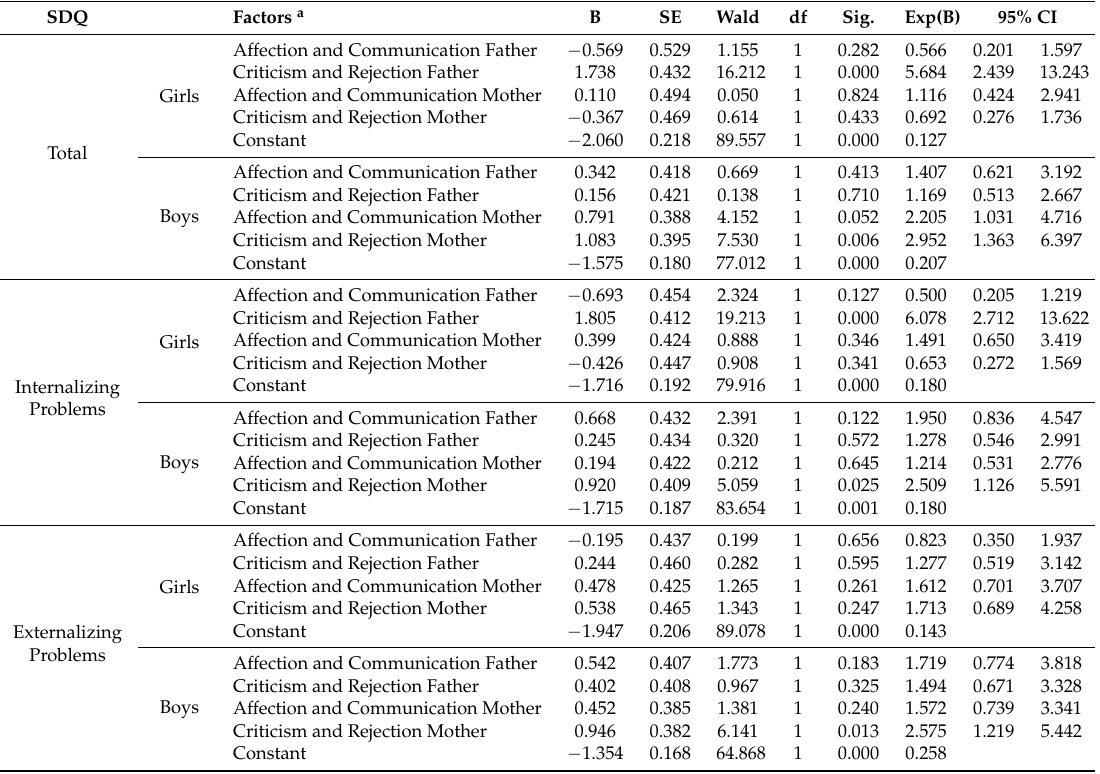
Table 2. Results of the logistic regression analysis for the prediction of Mental Health Problems (Total SDQ) Internalizing Problems and Externalizing Problems in girls and